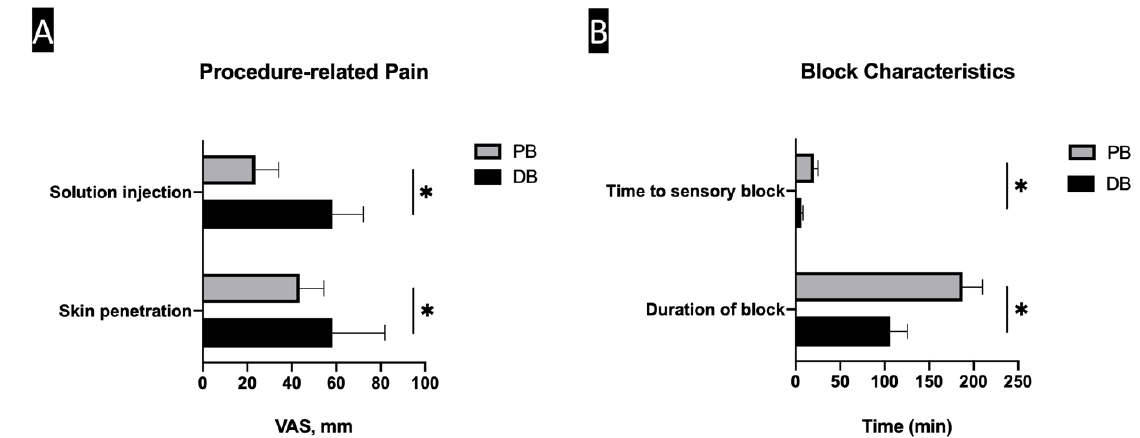
Figure 2. Bar graphs showing the Procedure-related pain ( A ) and block characteristics ( B ) in two groups. ( A ) The popliteal sciatic nerve block (PB) group showed significantly lower procedure-related pain than the digital nerve block (DB) group. ( B ) Time to sensory block and the duration of sensory block was significantly longer in the PB group. * statistically significant ( p < 0.001). Table 2. Comparison of block characteristics and adverse events between groups a